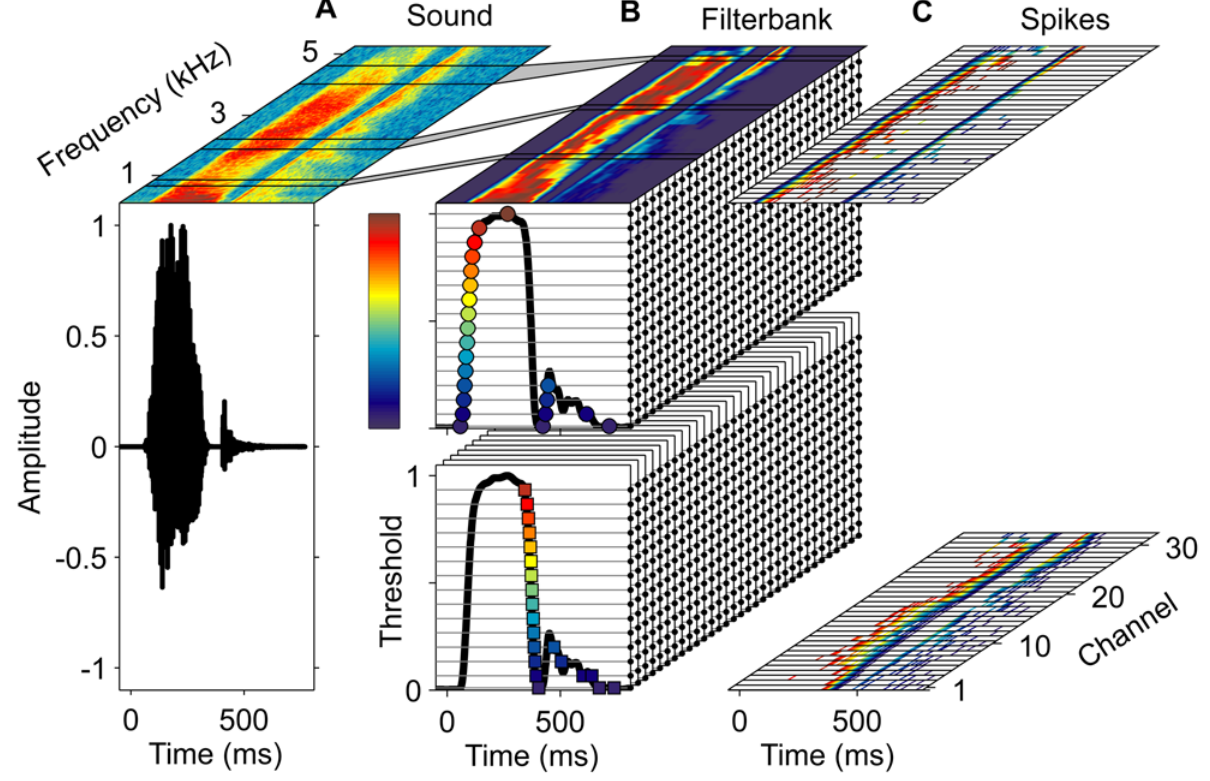
Figure 6. Auditory front end. (A and B) Incoming sound signal (bottom) and its spectrogram in linear scale (top) as in Figure 1D (A). Based on the spectrogram, the log signal power in 32 frequency channels (Mel scale, see Materials and Methods) is computed and normalized to unit peak amplitude in each channel ([B], top, colorbar). Black lines delineate filterbank channels 10, 20, and 30 and their respective support in the spectrogram (connected through grey areas). In each channel, spikes in 31 afferents (small black circles) are generated by 16 onset (upper block) and 15 offset (lower block) thresholds. For the signal in channel 1 (shown twice as thick black curves on the front sides of the upper and lower blocks), resulting spikes are marked by circles (onset) and squares (offset) with colors indicating respective threshold levels (colorbar). (C) Spikes (onset, top, and offset, bottom) from all 992 afferents plotted as a function of time ( x -axis) and corresponding frequency channel ( y -axis). The color of each spike (short thin lines) indicates the threshold level (as used for circles and squares in [B]) of the eliciting unit.